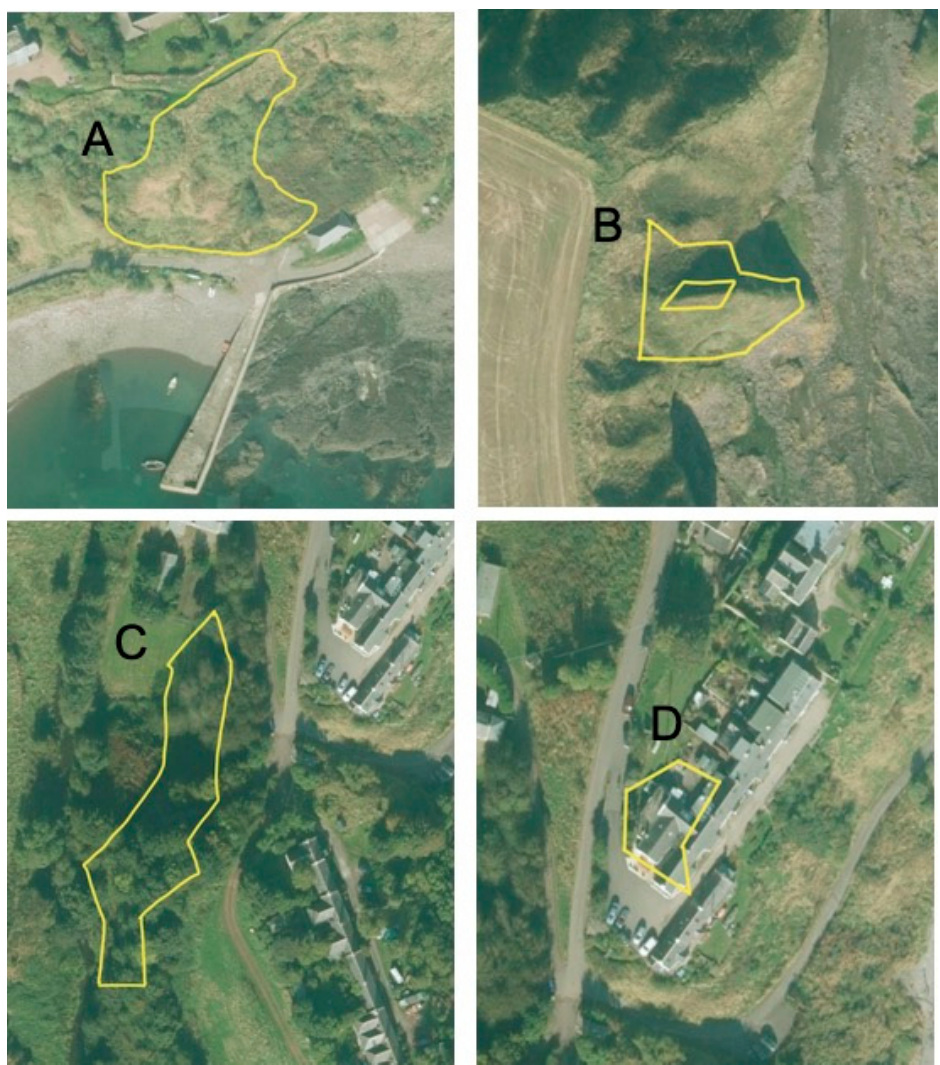
Figure 7. Polygons ( A ) and ( B ) were detected by the proposed tool on zones with signs of landslides whilst polygons ( C ) and ( D ) were detected as “false” positives (see Figure 6). A landslip event occurred in the area delimited in polygon ( A ) in February 2020 (see Figure 8). Source Images: [30].